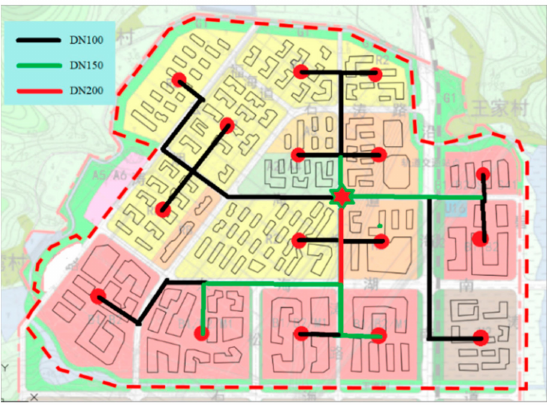
Figure 13. The network scheme with minimum cost as the objective of optimization.